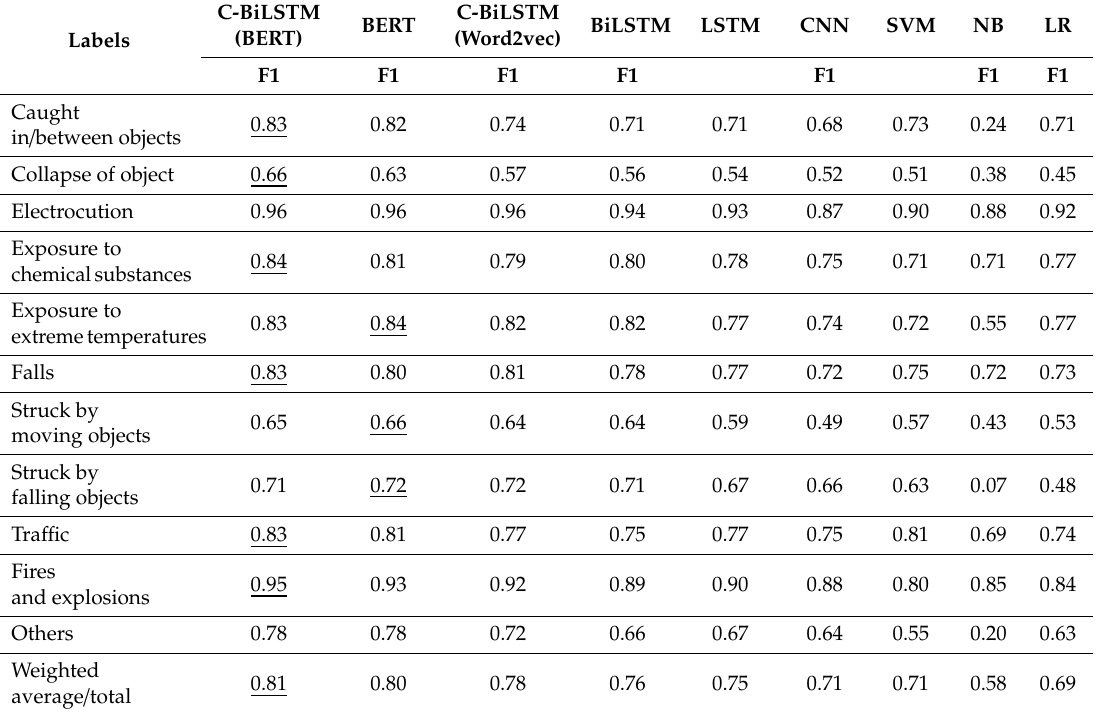
Table 3. Comparison of results of the C-BiLSTM-based model and baseline